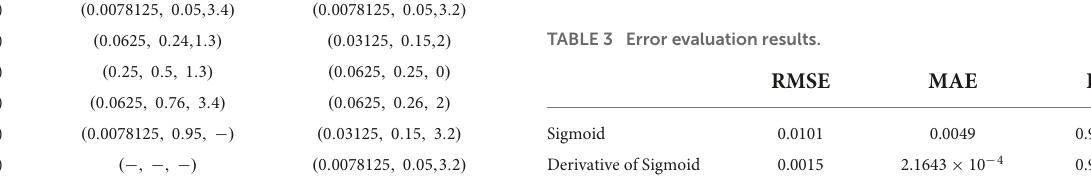
the counter reaches 200, the ping-pong switch is sloped to the forward side. At the beginning of the forward phase, a clear signal is transmitted to all modules to reset the SNN to its initial state. There is a clear port, a forward phase enable port, and a target phase enable port in the synaptic plasticity module. In the forward phase, the forward phase enables signal = 1, and the target phase enables signal = 0. In the target phase, the settings are the opposite. More details of control signals are shown in Figure 6 . The outputs of SNN are spike trains. Each output neuron has a dedicated counter that counts the soma spikes. The location of the output neuron with the most spikes is considered the prediction of SNN.